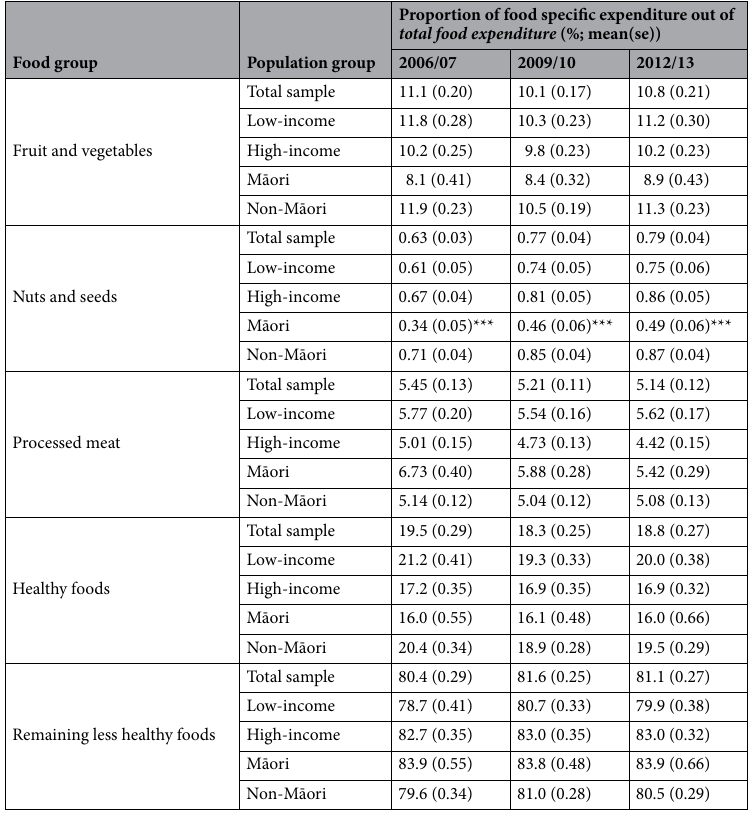
Table 4. Means of proportion of specific food expenditure out of total annual household food expenditure by food group, income-level and ethnicity in three HES waves: 2006/07, 2009/10, and 2013/13. *,**,***Denote statistical significance at the 10%, 5% and 1% levels, respectively.